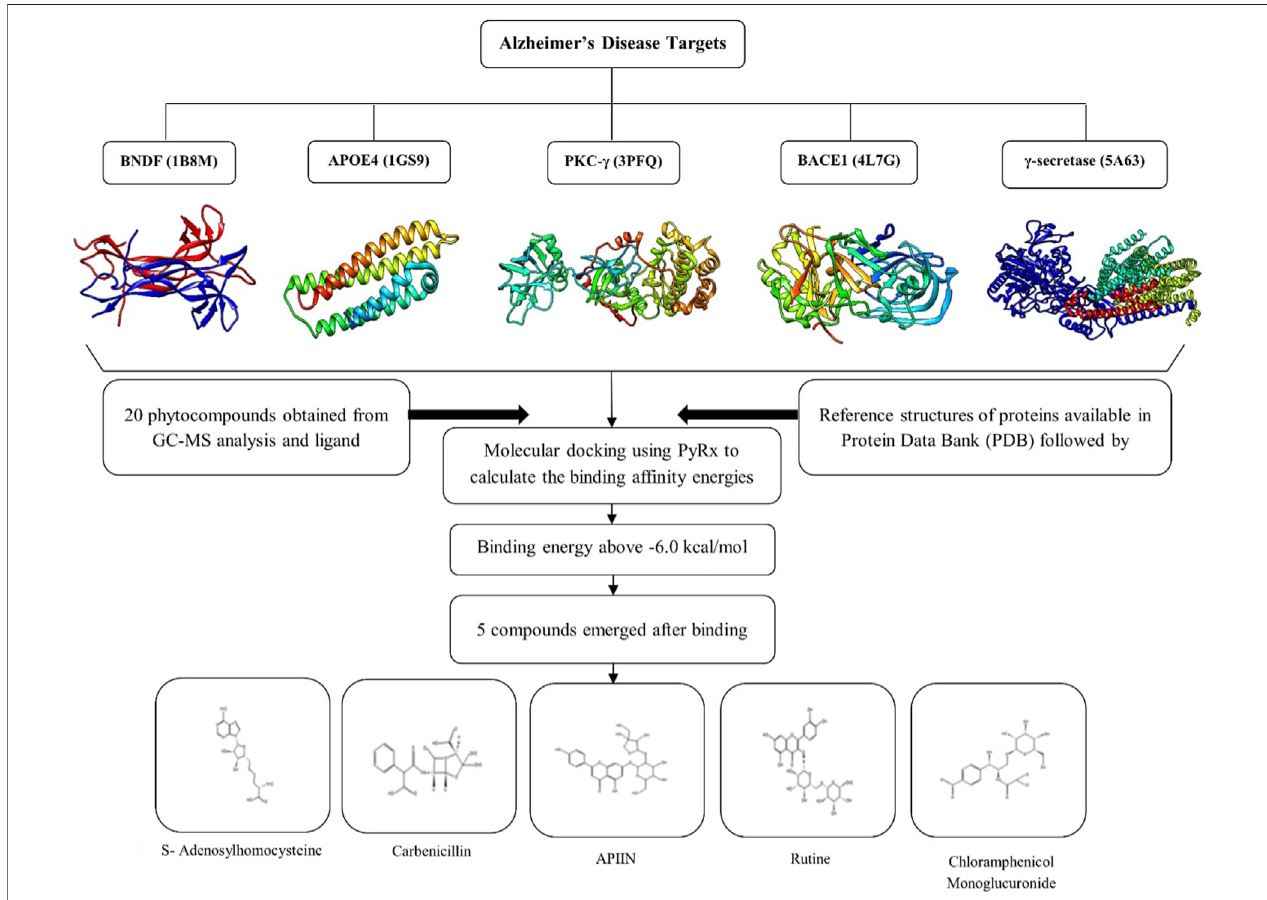
FIGURE 1 | Graphical representation of i n silico analysis carried out in the present study and the 3D structure of selected proteins.